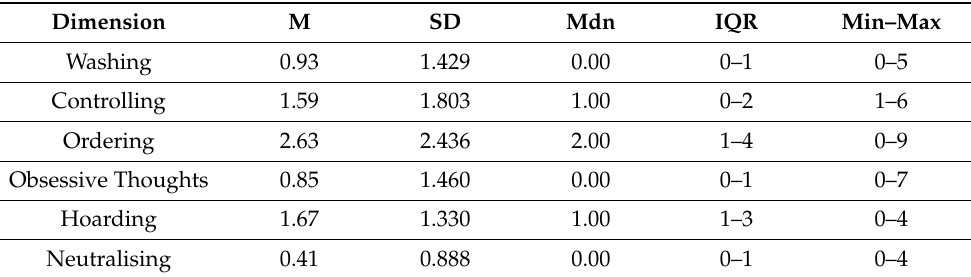
Table A12. Scores in the Obsessive Compulsive Inventory-Revised (OCI-R) of healthy control subjects ( n = 27). Abbreviations: IQR, interquartile range; M, mean; Max, maximum; Mdn, median; Min, minimum; SD, standard deviation.